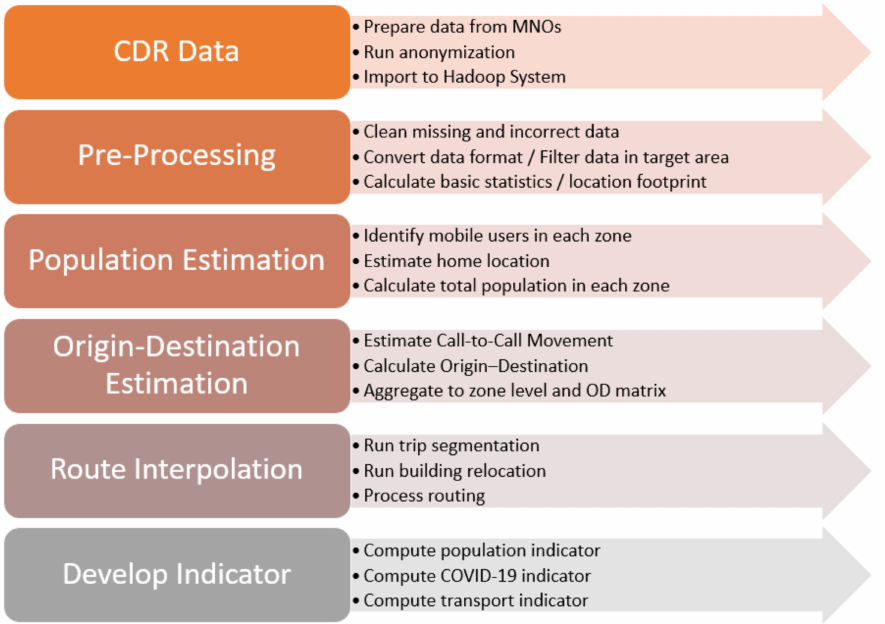
Figure 2. An example of the processing steps for the mobility analysis of CDR